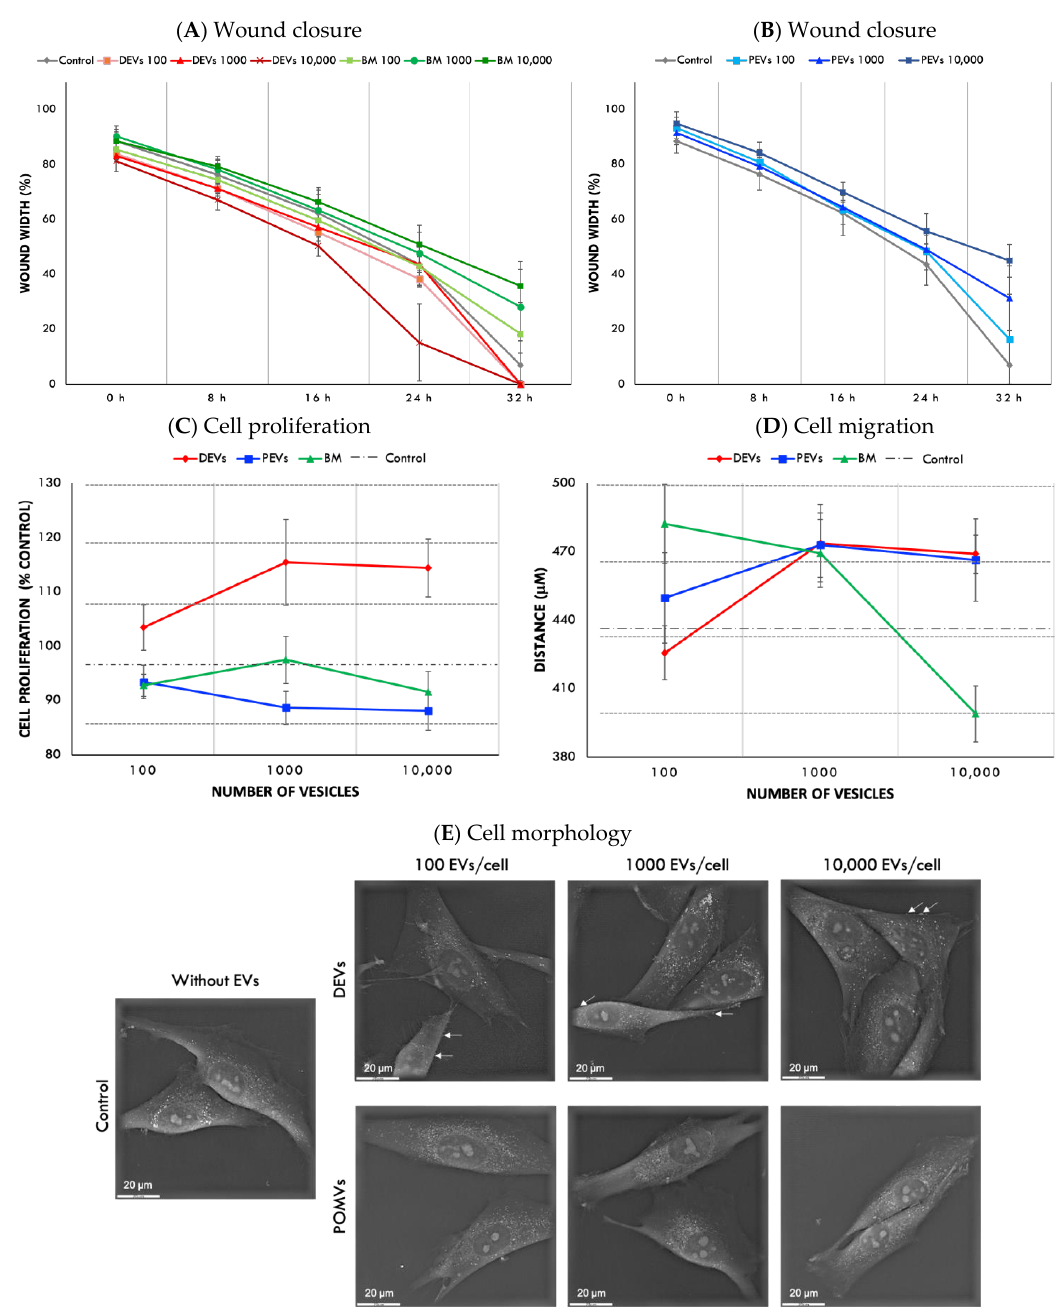
Figure 3. Effect of EVs on cell responses and function. ( A ) Wound closure of cells treated with DEVs and BM and ( B ) wound closure of cells treated with PEVs. Points represent means of two independent experiments carried out in quadruplicates and error bars show the confidence intervals ( α = 0.05) of wound width (μm) at 0, 8, 16, 24, and 32 h, n = 8. ( C ) Osteoblast proliferation (% control), CCK-8, n = 8. Points represent means of two independent experiments carried out in quadruplicates and error bars show confidence intervals ( α = 0.05). ( D ) Individual osteoblasts migration (total distance µ m), Cell Tracking, n = 20. Points represent the means of two independent experiments, and error bars represent confidence intervals ( α = 0.05). ( E ) Osteoblast morphology after 1 h in contact with EVs at different concentrations (NanoLive). White arrows indicate the presence of membrane exfoliate structures on the osteoblast surface ( ×